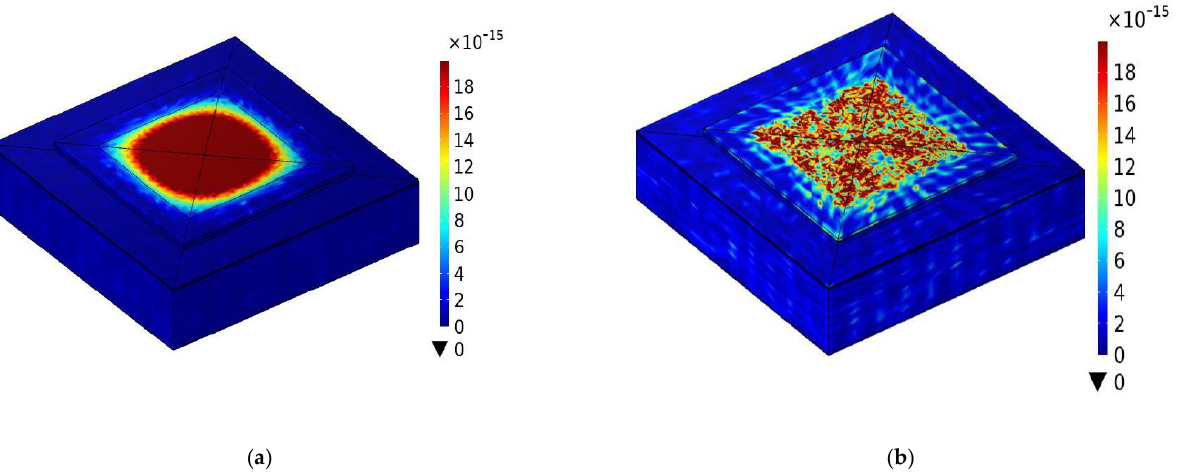
Figure 4. The eigen − mode of FBAR at resonance with ( a ) planar electrode and ( b ) fractal electrode. (The unit of displacement in the legend is µm).